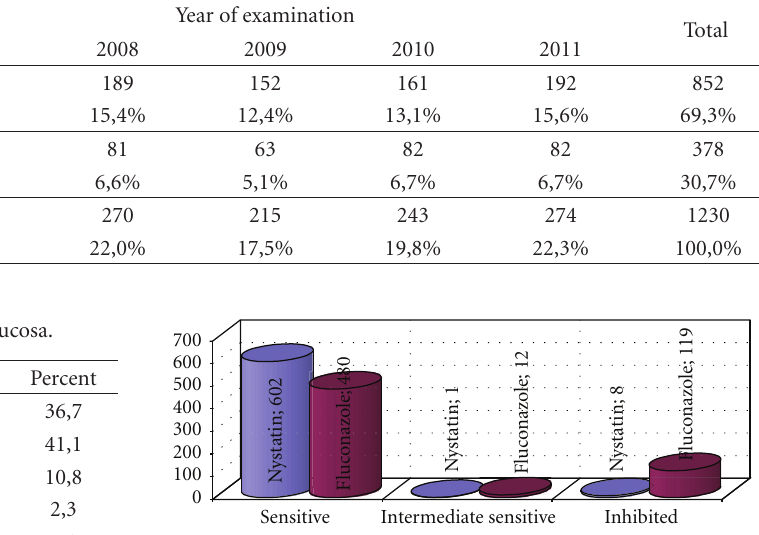
Figure 4: Susceptibility of yeasts of intermediate, intensive, and abundant growth to Nystatin and